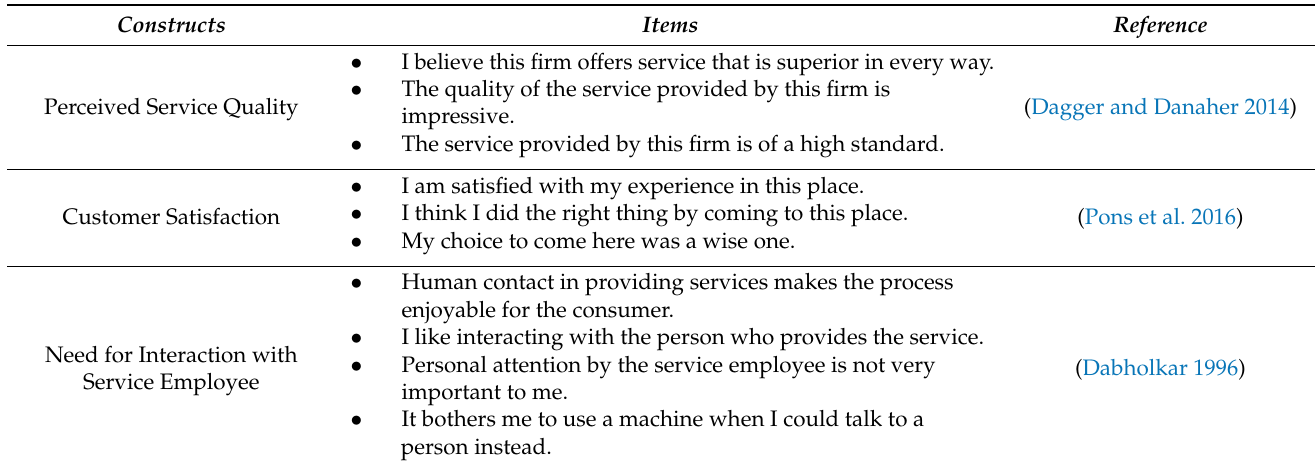
Table 1. Measurement instruments of main variables (5-point Likert Scale).